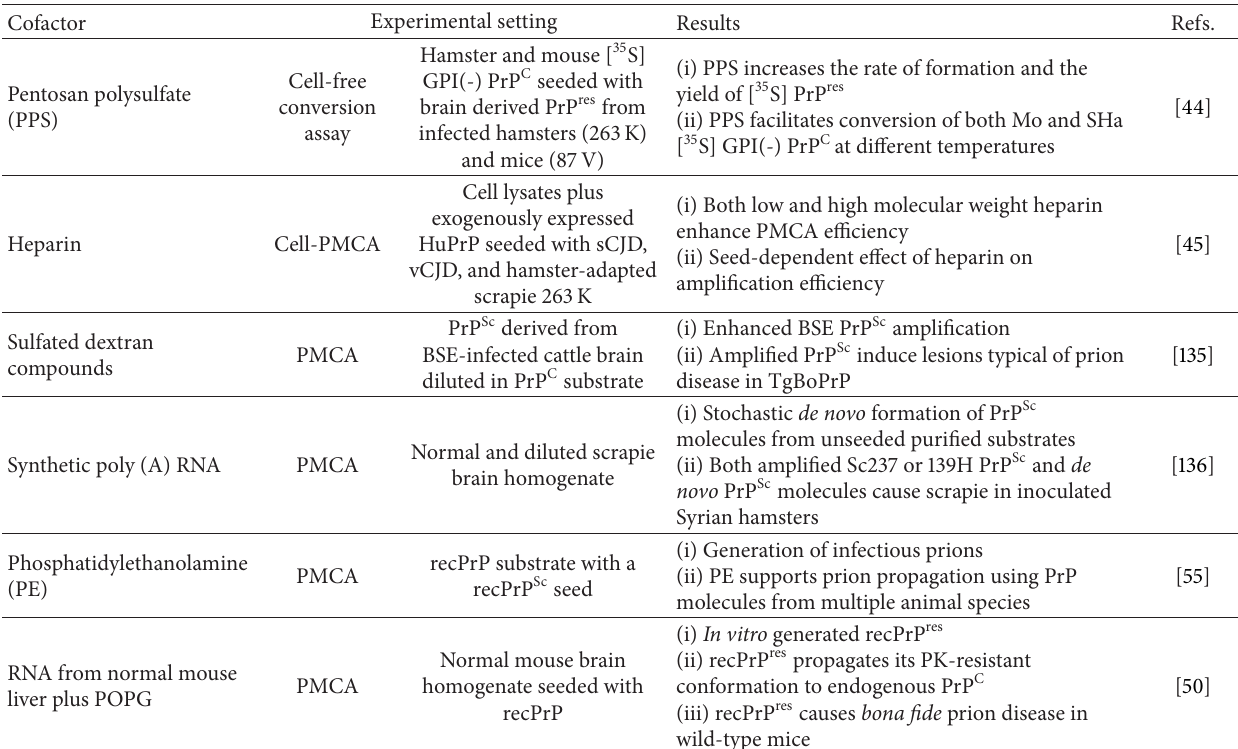
Table 1: Cofactors enhancing PrP C conversion in vitro